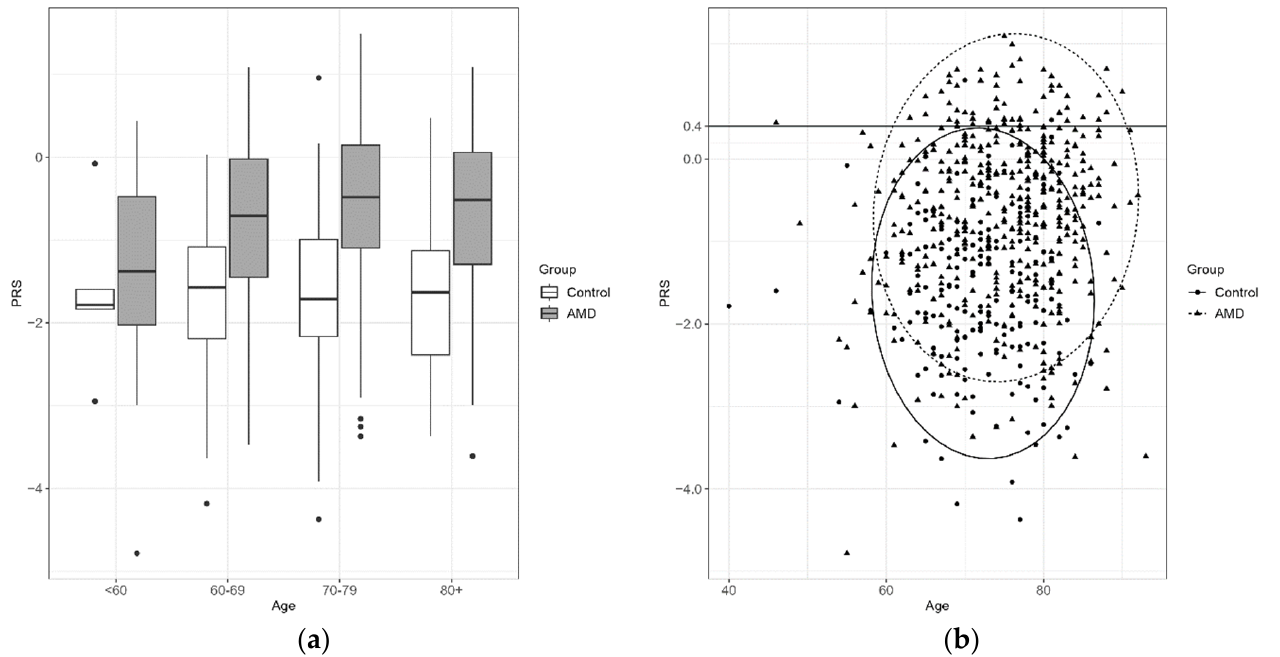
Figure 4. PRS by age ( a ) Boxplot showing the differences in mean PRS in age groups for controls and AMD cases; ( b ) Values of PRS depending on age for controls and AMD cases with 95% confidence level ellipse. The horizontal line corresponds to the 10th decile cut-off at 0.4.